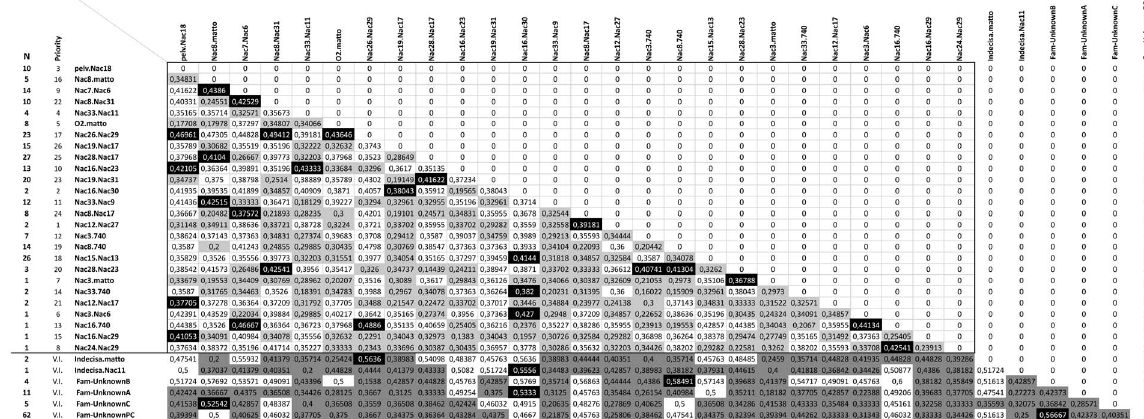
Figure 2. F1 breeding plan. Pairwise distances among the families of the ‘‘ Breeders Unit ’’ estimated by comparing the cumulative profiles of the parent pairs. The black frame includes distances estimated at 24 loci and excludes the ones based on 7 loci only. Light grey and dark grey cells represent crosses to be avoided based on threshold values of 0,35 (at 24 loci) and 0,45 (at 7 loci), respectively. Black cells represent selected crosses identified by the software ‘‘ BreedingPlanSturgeons ’’ (within the black frame) or by visual inspection (for the families marked with V.I.). N=number of individuals per family.